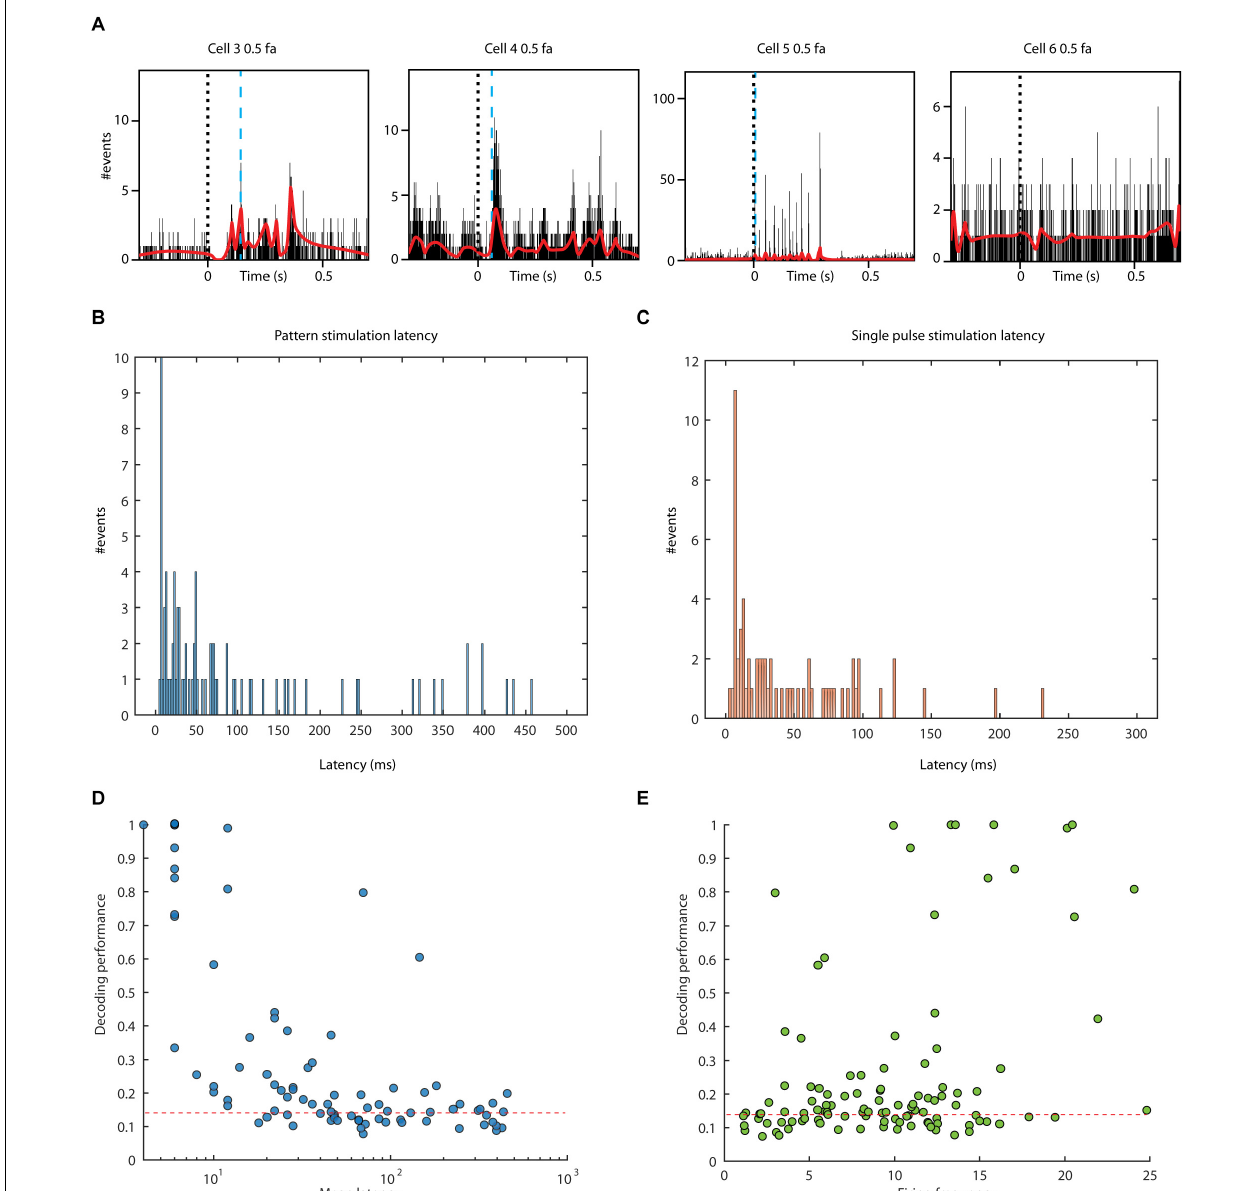
FIGURE 4 | Response latency times and their relationship to decoding performance. (A) PSTHs and KDEs of the responses to one stimulation pattern in four sample cells. The blue dashed line indicates the estimated response onset latency time in each case (note that the response latency time for each neuron was calculated using the responses from all eight stimulation patterns). No response latency time could be identified for the neuron to the far right. (B) All detected response latency times for neurons during stimulation patterns. (C) All detected response latency times based on responses evoked by single pulse stimulation. (D) Relationship between decoding performance (F1-score) and the logarithm of the response latency time for pattern stimulation. Dashed red line indicates the decoding level threshold defined in Figure 3E . (E) Relationship between the decoding performance and the average firing